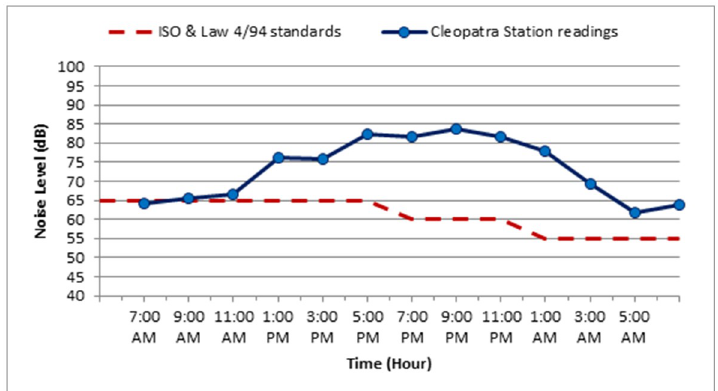
Environmental law 4/94.